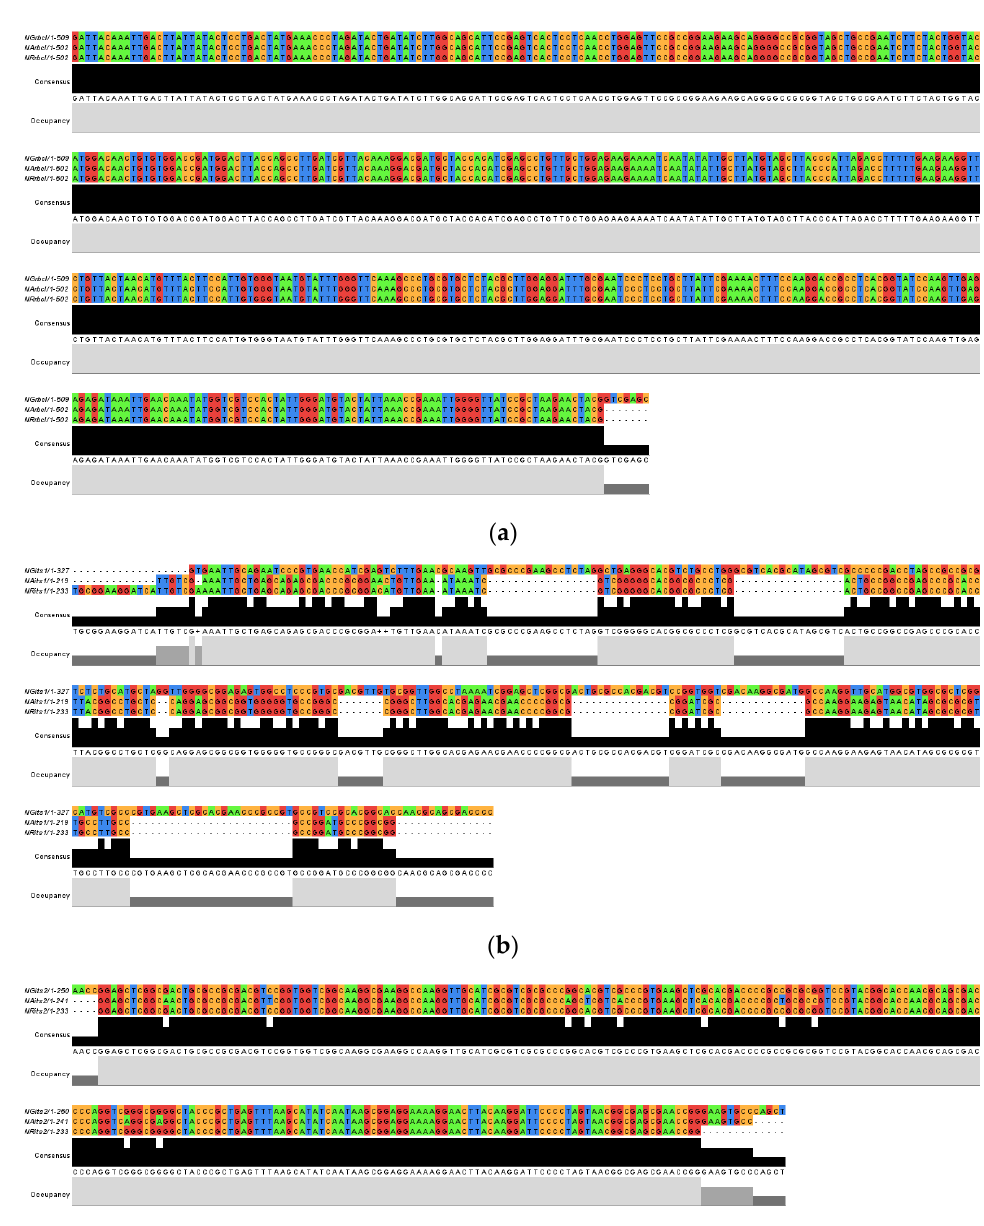
Figure 2. Multiple sequence alignment of rbc L ( a ), ITS1 ( b ) and ITS2 ( c ) barcodes. Table 5. The average AT and GC percentage nucleotide composition of N. gracilis, N. ampullaria and N. rafflesiana based on rbc L, ITS2 and ITS1 DNA